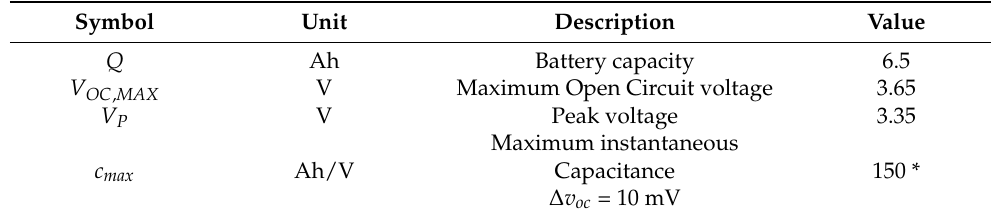
Table 1. Parameters for the LiFePO 4 battery